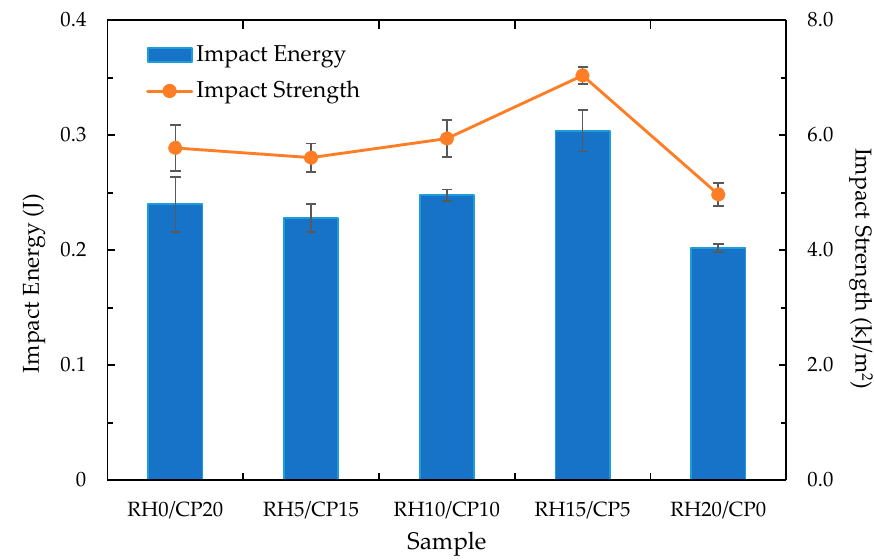
Figure 6. Typical flexural curves of RH/CP reinforced ABS blend composites.